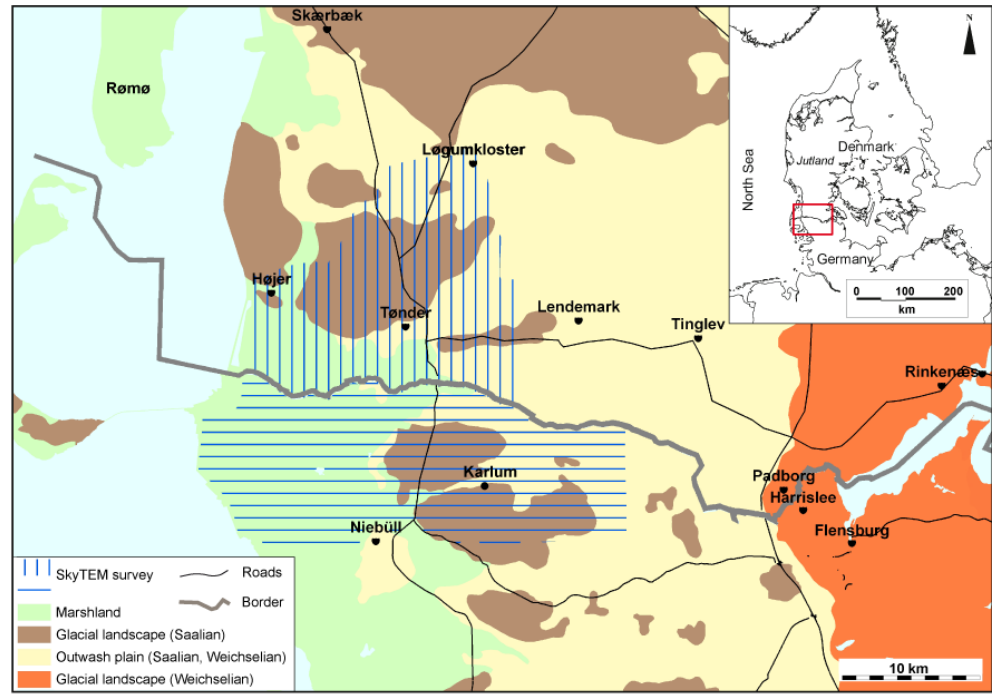
Fig. 1. Location and geography of the survey